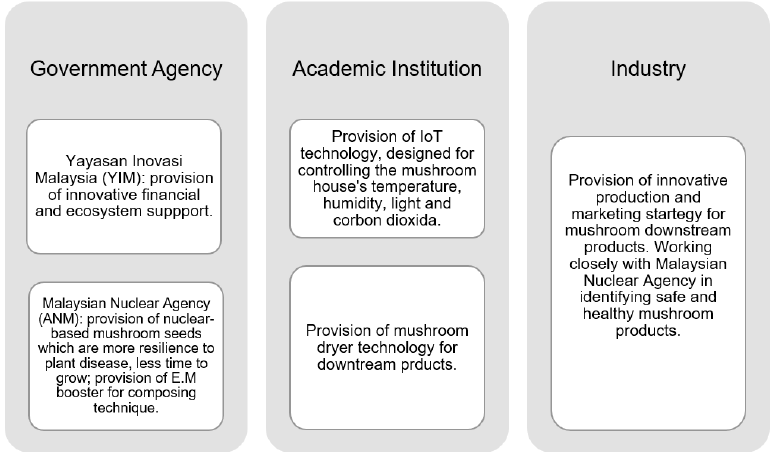
Figure 2. The KOKULAC partners and collaboration.